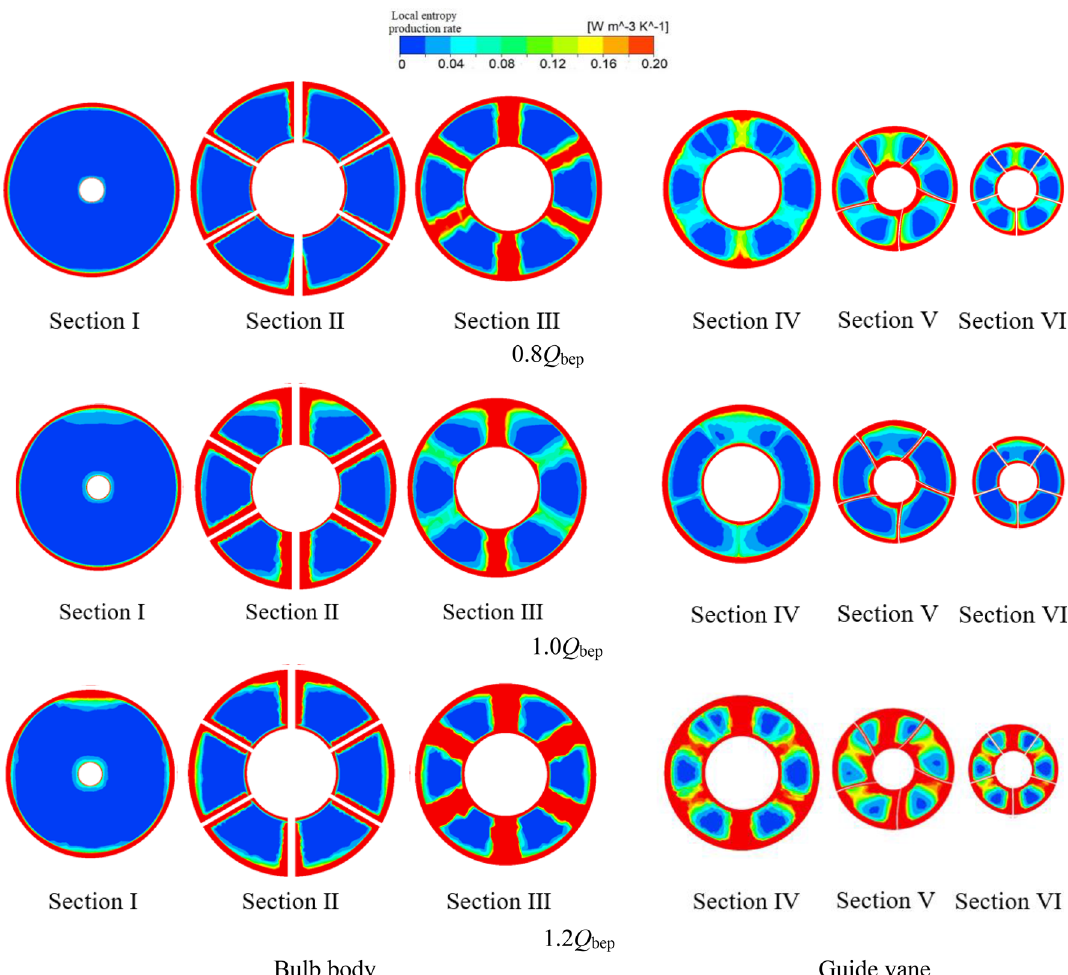
Figure 11. Local entropy production rate distribution of typical cross sections of the bulb and guide